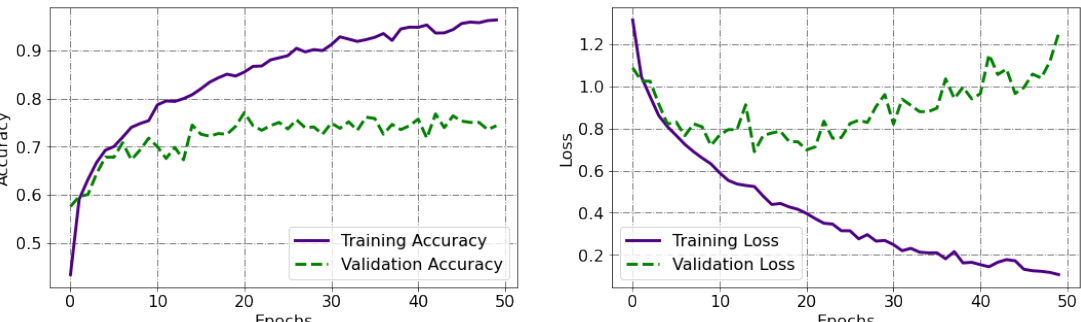
Figure 11. Model performance with data augmentation.